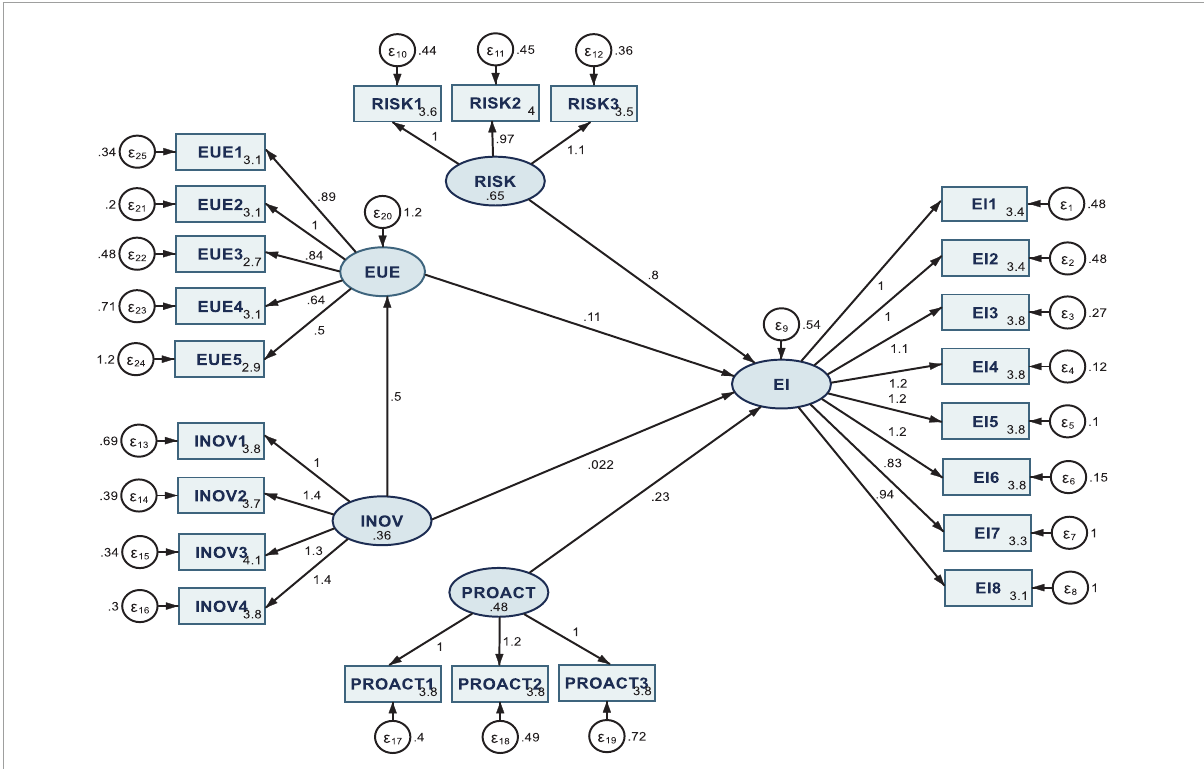
FIGURE4 Results of SEM 3 model processed on the sub-sample considering that COVID-19 does not influence the entrepreneurial intention. Authors’ research in Stata